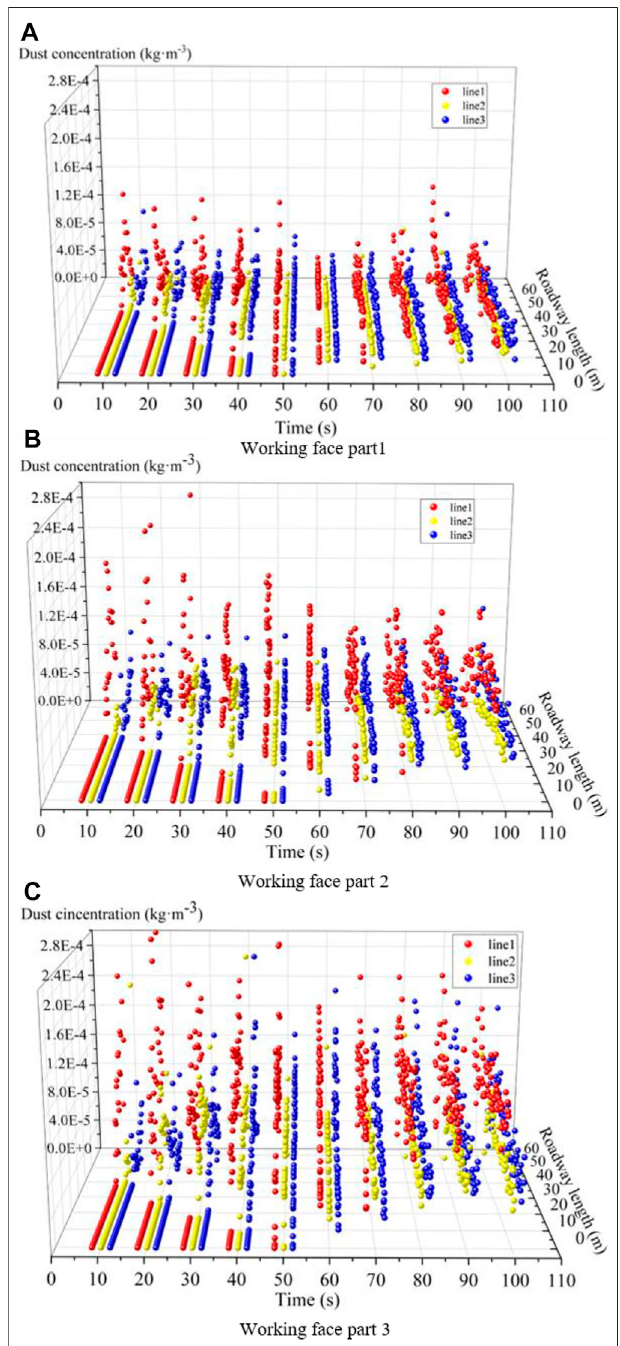
FIGURE 5 | Variation of dust concentration along the process: (A) Working face part 1; (B) Working face part 2; (C) Working face part 3.